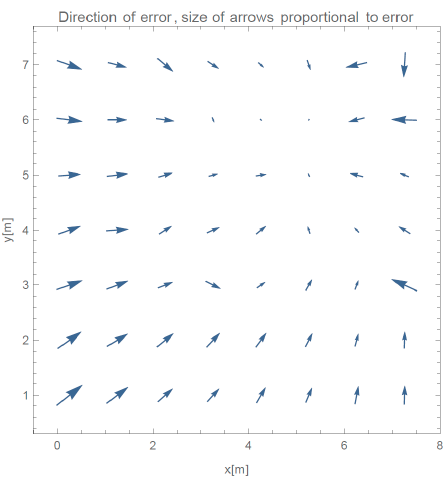
Figure 17. Error directions at the unusual event on Thursdays of the 8th week.